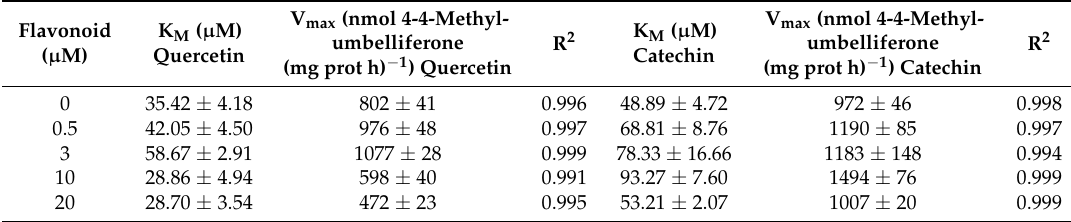
Table 4. QC and CA modulation of the chitinase activity of S. griseus . Chitinolytic activity by chitinase from S. griseus was measured using 4-methyl-umbelliferyl β triacetyl chitotrioside as a substrate, as described in the Material and Methods section. The enzyme activity was assayed in the absence and in the presence of different concentrations of QC and CA. The apparent Michaelis-Menten parameters were obtained at each substrate concentration, by fitting data to the Michaelis-Menten